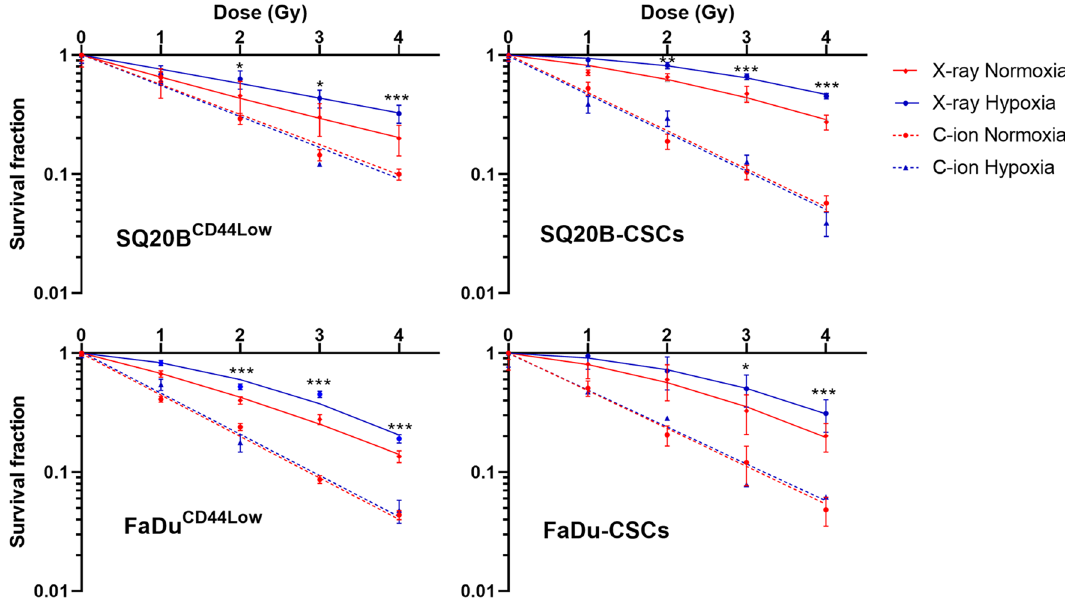
Figure 1. Clonogenic survival curves. SQ20B CD44Low , FaDu CD44Low , SQ20B-CSCs and FaDu-CSCs were exposed to photons or carbon ion irradiation under normoxia or chronic hypoxia. The survival fractions ± SD were presented in response to an irradiation of 1, 2, 3 and 4 Gy. Student’s t -test was performed between survival fractions of normoxia and hypoxia curves for each cell line (* P < 0.05, ** P < 0.01 and *** P < 0.001).